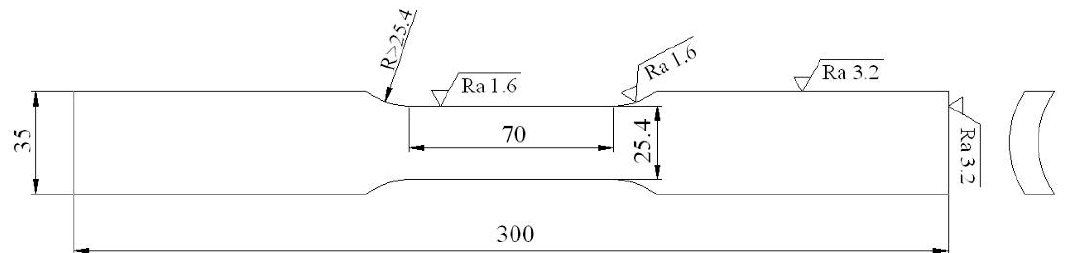
Figure 15. Geometry and dimensions of the tensile specimen.